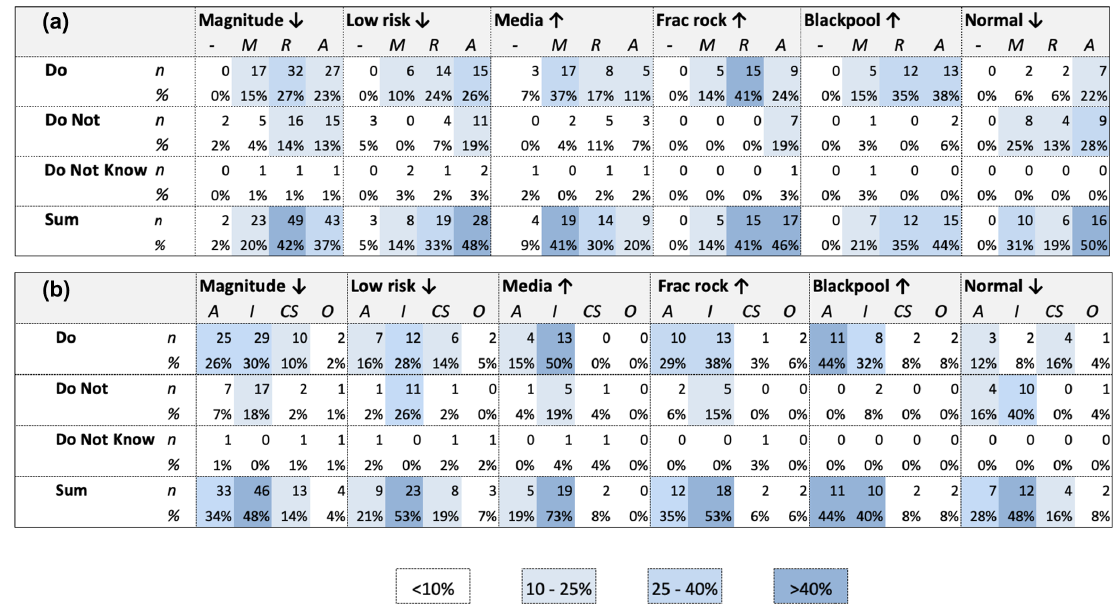
Table 6. Code frequency and (a) different information sources (for all participants) and (b) employment sector (for conference attendees) for the six most frequent codes (organised from left to right in order of code frequency). Information sources in panel (a) include no source (–), media (M), reports (R), and (A) research (academic) papers. Information in panel (b) about the employment sector was asked for conference attendees only and includes academia (A), industry (I), civil service (CS), and other (O). The count for each code is normalised to the total count for that code. These values are then colour coded, as shown in the key, to indicate where codes are used by particular knowledge or employment groups or to support particular